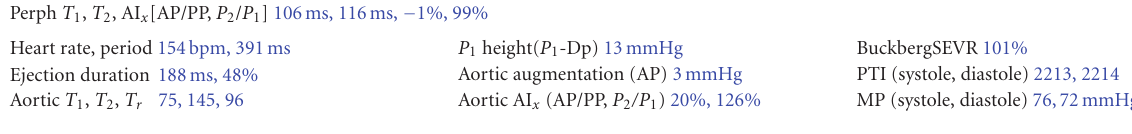
Figure 1: Pulse wave recording of a 13-year-old male bonnet macaque weighing 9.5 kg.